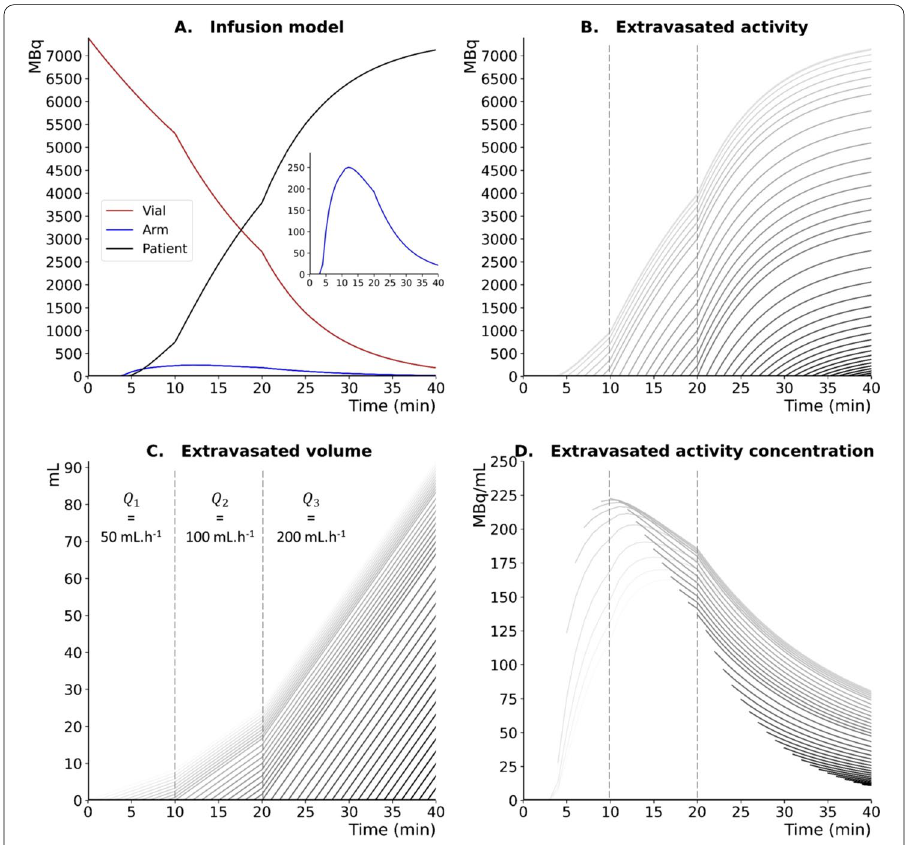
Fig. 6 Evolution of simulated activity in the vial (red curve), arm (blue curve) and abdomen (black curve) for nonextravasated infusion ( A ). Evolution at the patient’s arm of simulated activity ( B ), volume ( C ) and activity concentration ( D ) for infusions that extravasate with onset times ranging from 1 to 40 min with 1-min sampling (gray